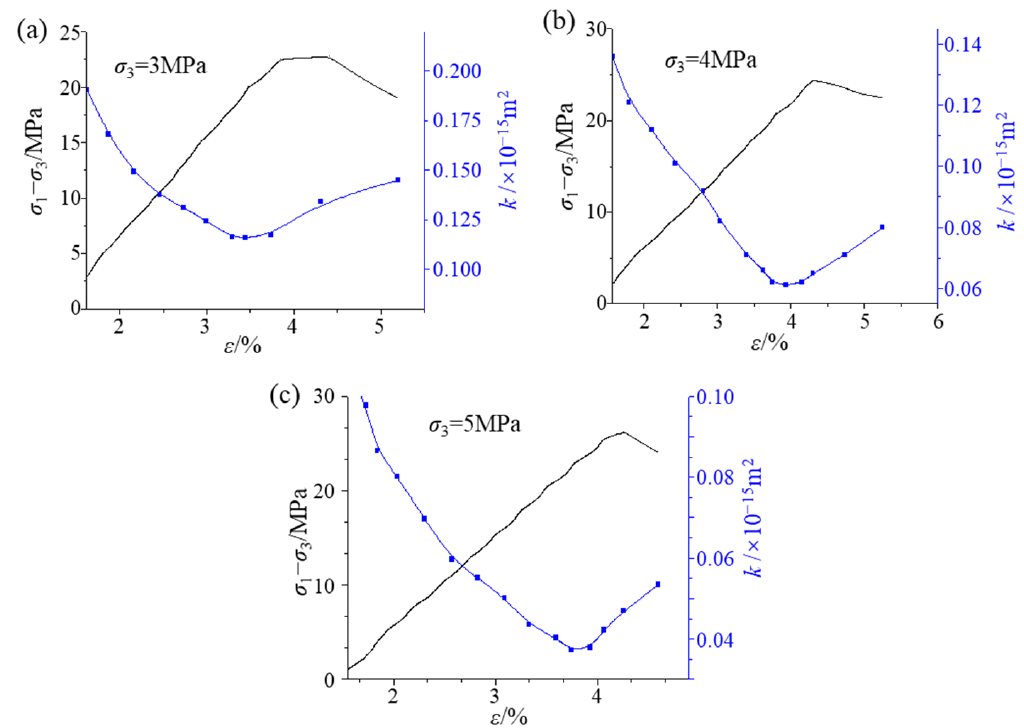
Figure 10. Deviatoric stress–strain (black line) and permeability evolution of coal under confining stresses (blue line); ( a ) 3 MPa; ( b ) 4 MPa and ( c ) 5 MPa.